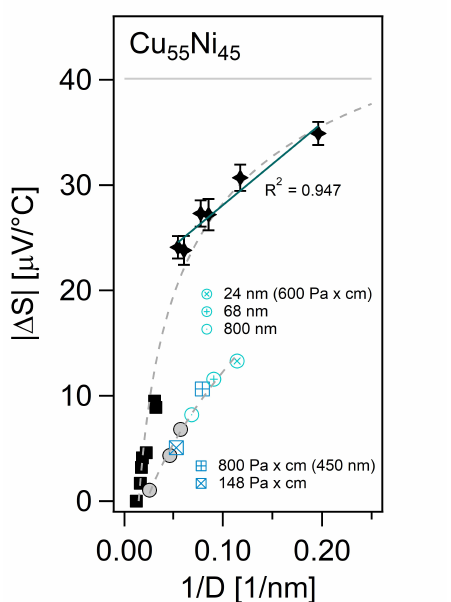
Figure 5. Deviation of the thin film Seebeck coefficient from the bulk value as function of the inverse of the domain size. The data derived from the work of Barber et al. [26] on sputter deposited constantan films are represented by the blue square unfilled markers (varying P × d , constant thickness), the blue round unfilled markers (varying thickness, constant P × d ) and the round gray filled markers (both varying P × d and layer thickness). The full gray line represents the value for the maximal deviation | ∆ S | max . The gray dotted lines are a guide to the